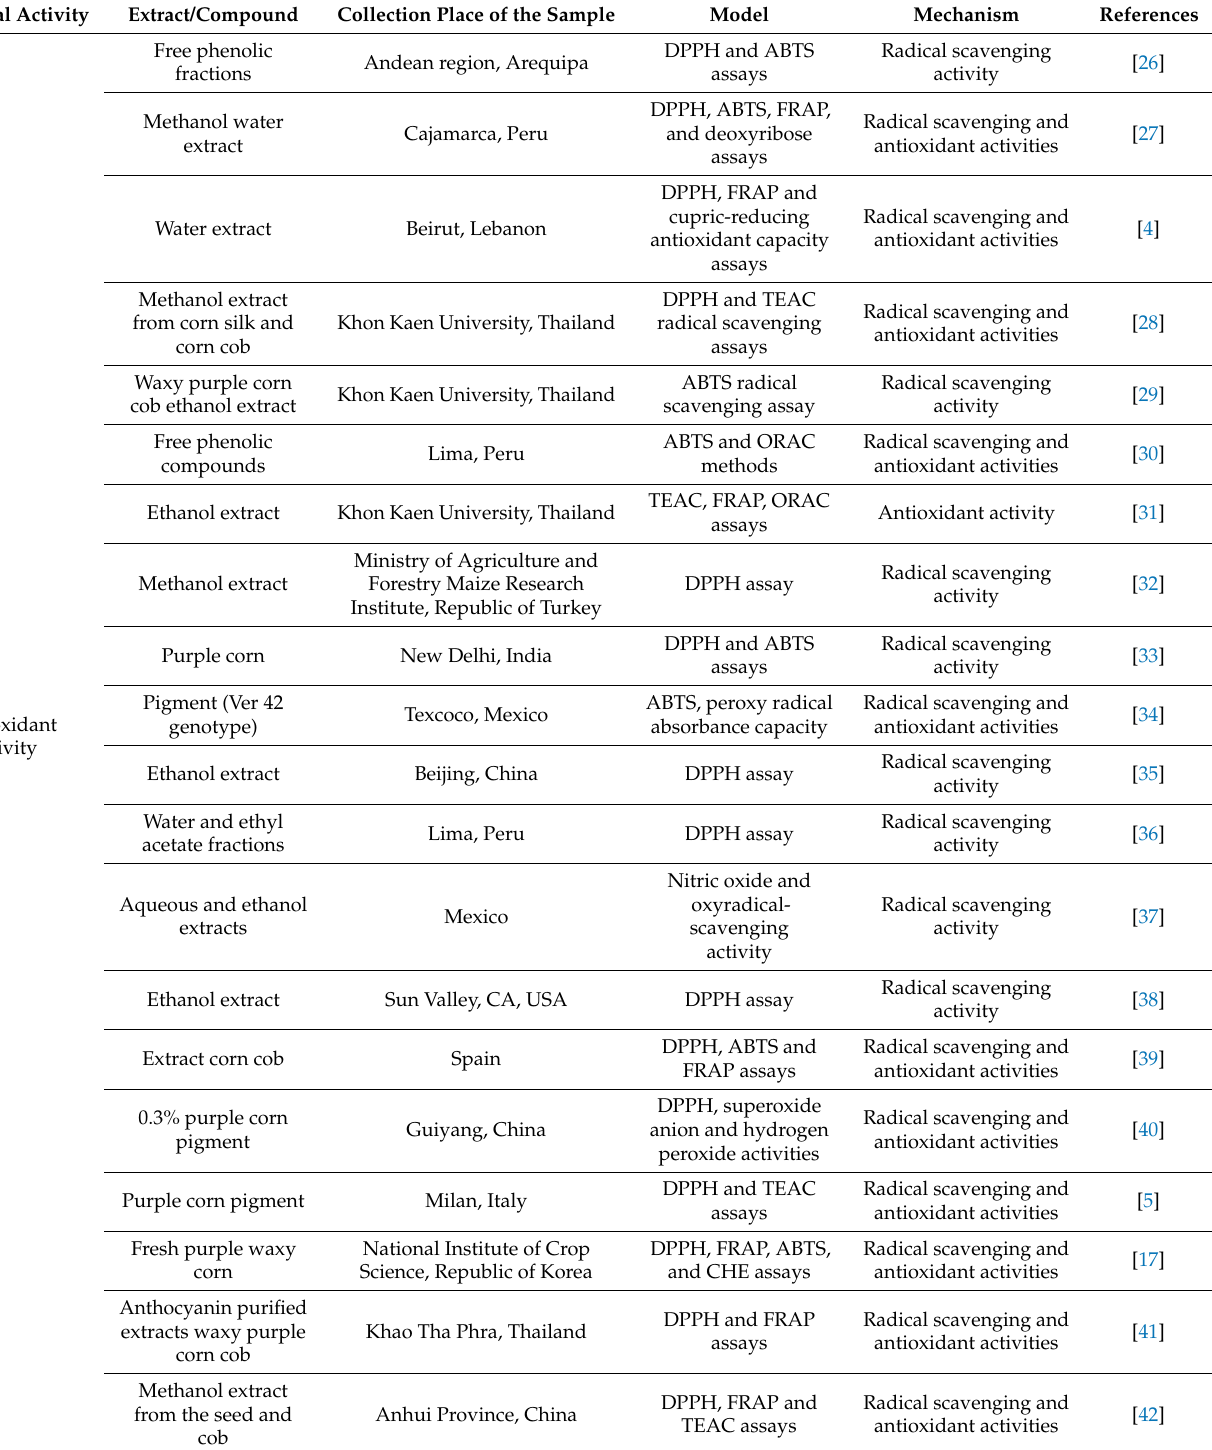
Table 1. In vitro biological properties of extracts and compounds from purple